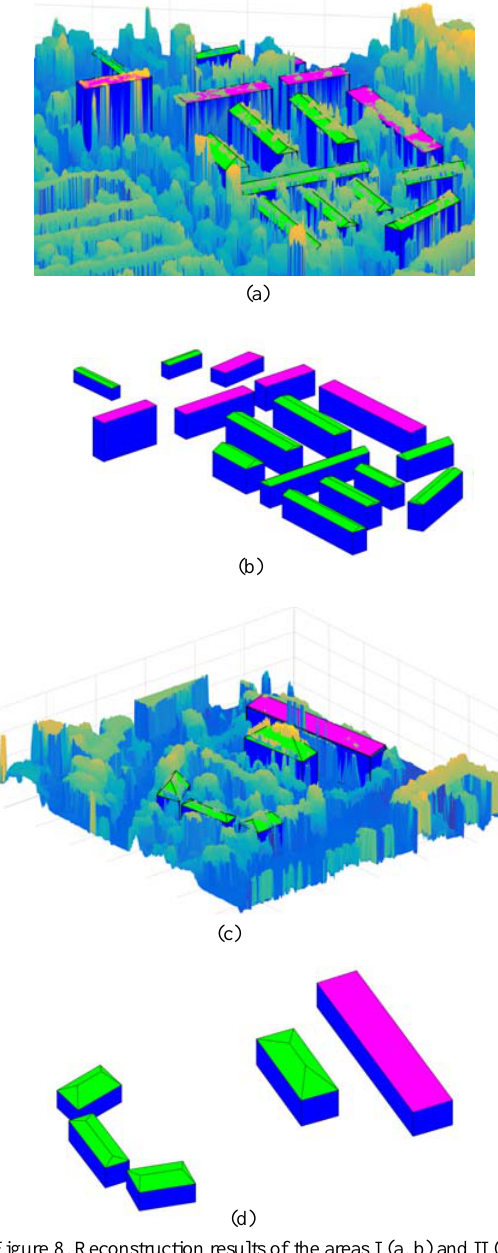
Figure 8. Reconstruction results of the areas I (a, b) and II (c, d). Flat roofs and pitched roofs are shown in purple and green color,